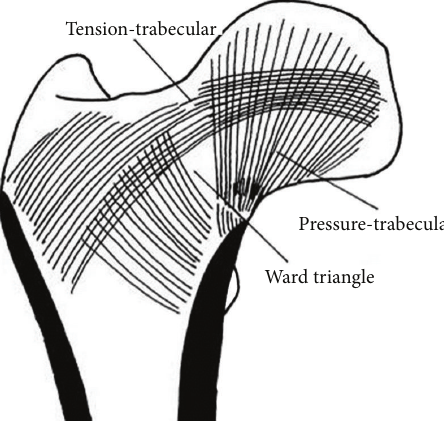
Figure 1: Model of the femur with orientation structure based on biomechanical